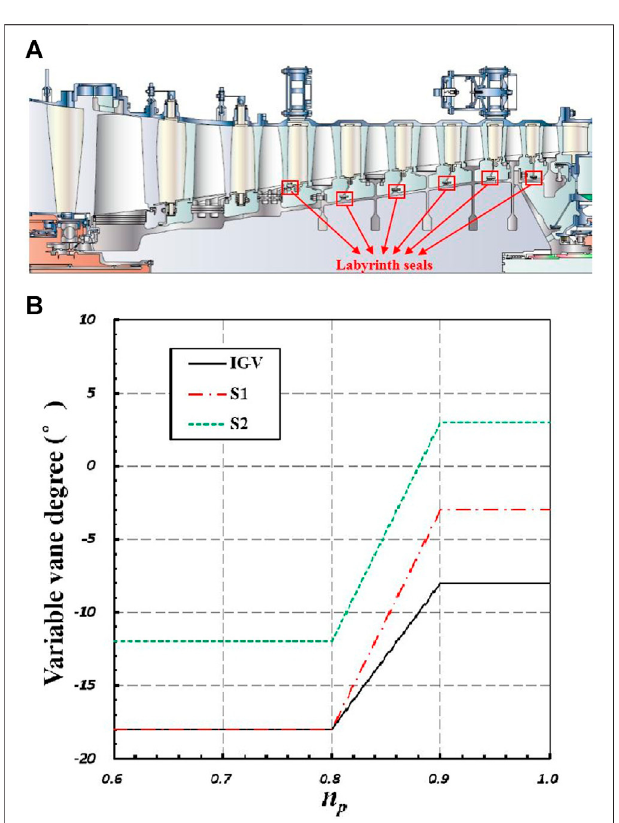
FIGURE 2 | Basic structural parameters of the nine-stage axial compressor. Main structures of the nine-stage axial compressor (A) , Variable vane degree related to non-dimensional corrected rotation speed (B)